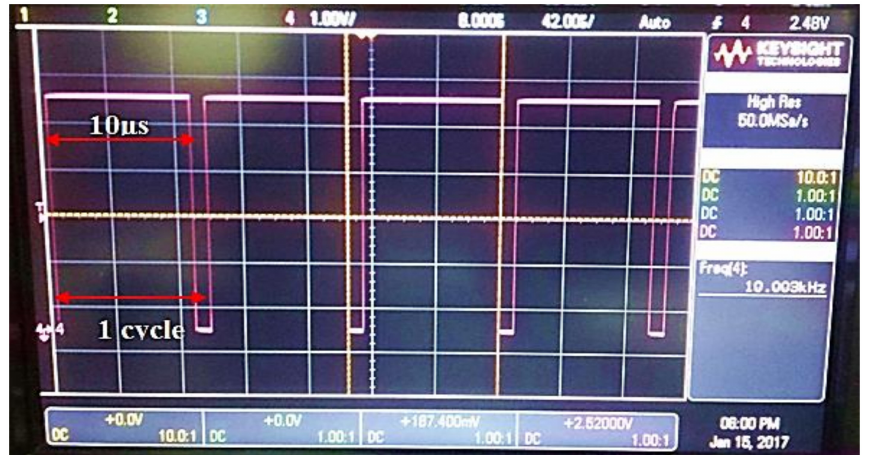
Figure 11. Oscilloscope snapshot of the pulse width modulation (PWM) switching signal for a MOSFET